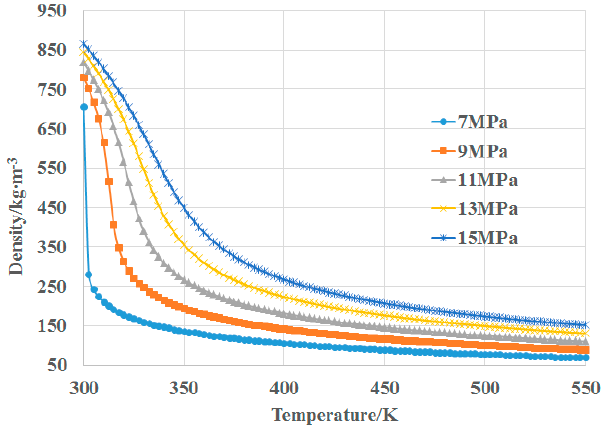
Figure 4. Density variation with temperature and pressure 3.3. Numerical validation.